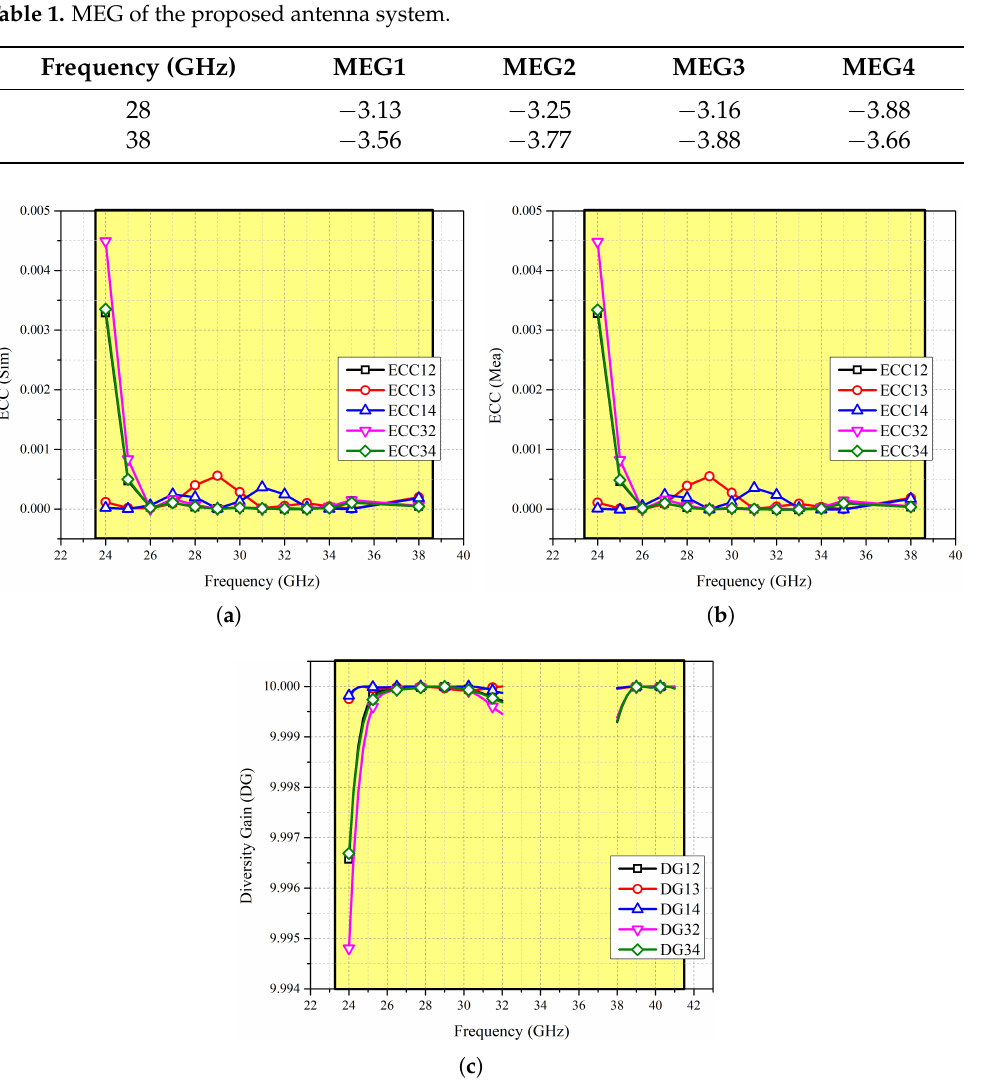
Figure 13. Olympeak antenna MIMO parameters ( a ) ECC Sim ( b ) ECC Mean ( c ) Diversity